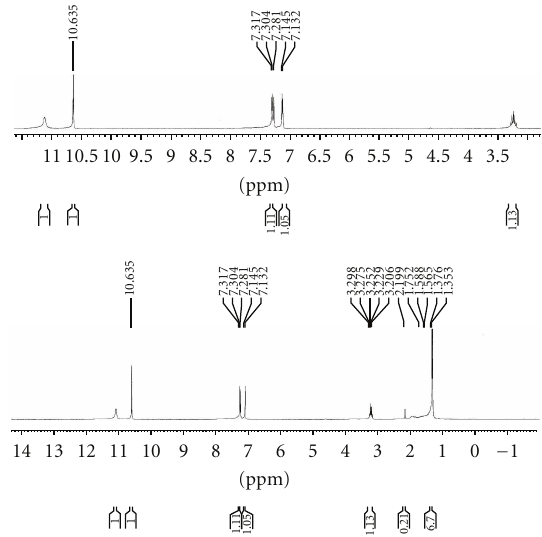
Figure 2: 1 H NMR spectrum of Schi ff base (HL 3